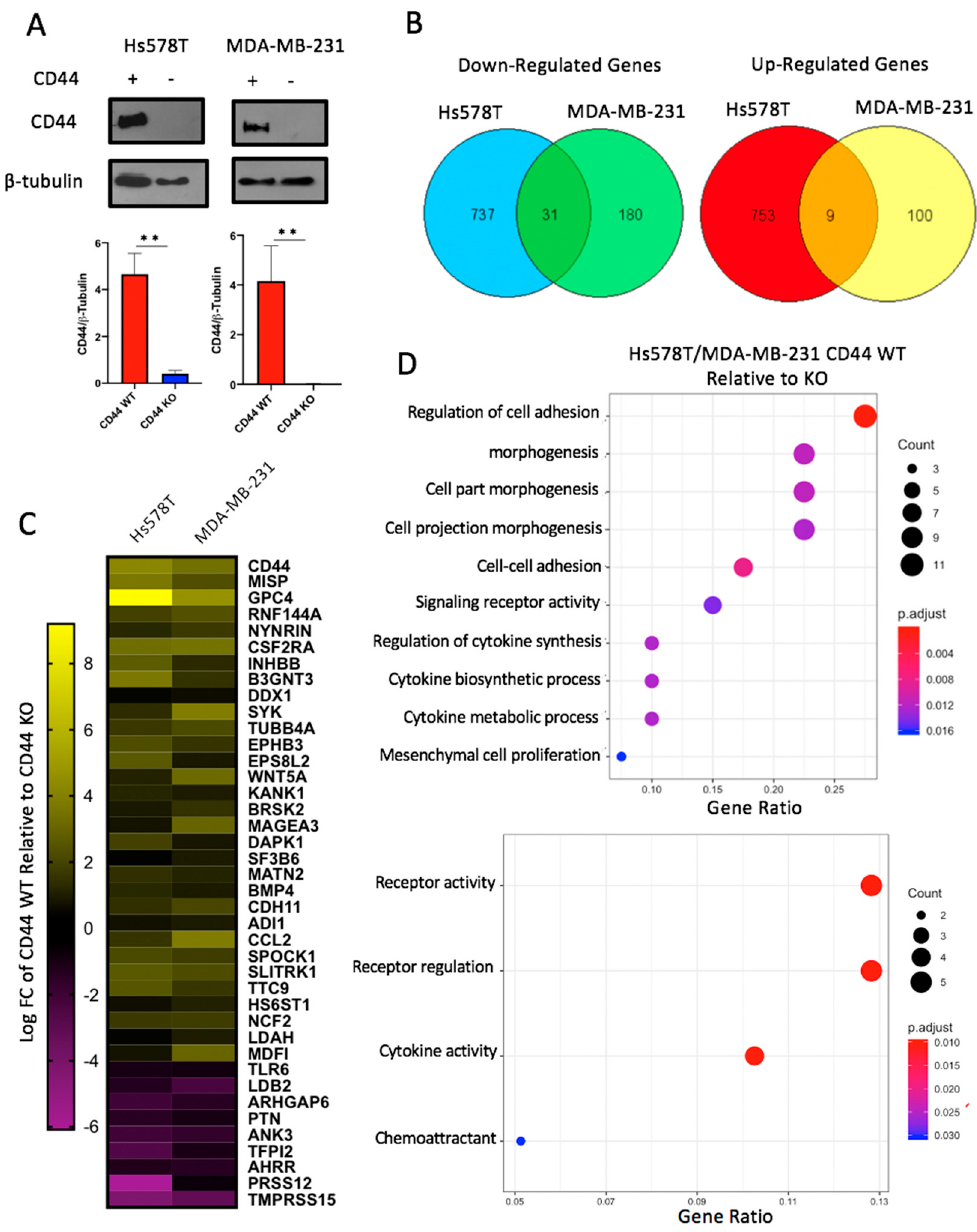
Figure 3. CD44 deletion in breast cancer cell lines decreases expression of genes involved in cellular adhesion and cytokine activity. ( A ) CD44 KO was confirmed via Western blot and compared to the loading control β -tubulin via densitometry. CD44 KO indicates that cells received gRNA targeting exons 1 and 5 of CD44. CD44 WT (CD29 +/ CD44 + ) and CD44 KO (CD29 +/ CD44 − ) cells were sorted and expanded in culture. ( B ) Venn diagram illustrating RNA sequencing results (submitted in triplicate). A total of 1530 and 320 genes were impacted by CD44 KO in the Hs578T cells and MDA-MB-231 cells, respectively. When comparing each of these data sets, 40 genes were di ff erentially expressed in both Hs578T and MDA-MB-231 cells upon deletion of CD44. ( C ) Heat map demonstrating log fold change of di ff erential gene expression in CD44 WT relative to CD44 KO Hs578T and MDA-MB-231 cells. ( D ) Gene ontology analysis identifying gene sets enriched in CD44 WT relative to CD44 KO Hs578T and MDA-MB-231 cells. Dot size represents the number of genes enriched within that pathway, while color represents an adjusted p -value.